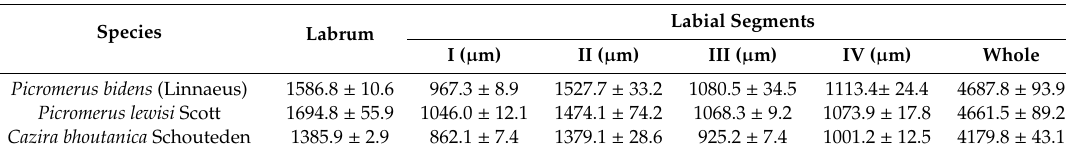
Figure 3. SEM images of the labrum and first labial segment. ( A ) Ventral view of Picromerus bidens ; ( B ) Ventral view of Picromerus lewisi ; ( C ) Ventral view of Cazira bhoutanica ; ( D ) Lateral view of Picromerus bidens ; ( E ) Lateral view of Picromerus lewisi ; ( F ) Lateral view of Cazira bhoutanica.